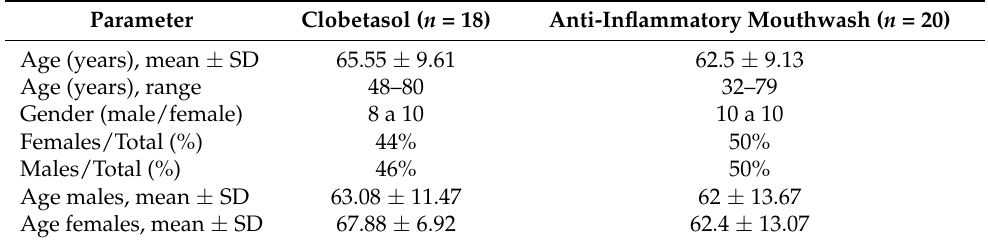
Table 1. Variation of the oral lichen planus (OLP) sign score after the administration of the two protocols adopted. SD, standard deviation.